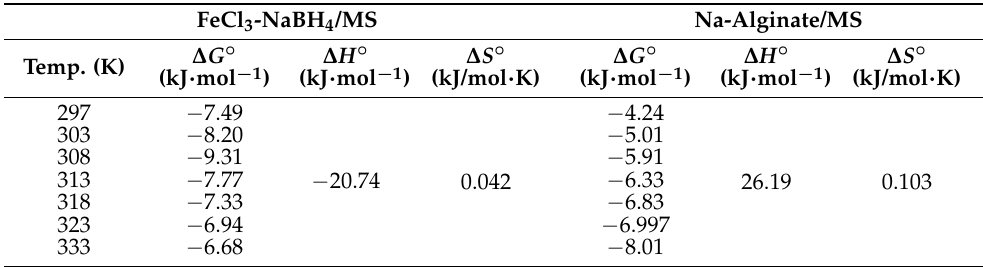
Table 3. Thermodynamic parameters for the adsorption of 2,4,6-TCP onto FeCl 3 -NaBH 4 /MS and Na-Alginate/MS